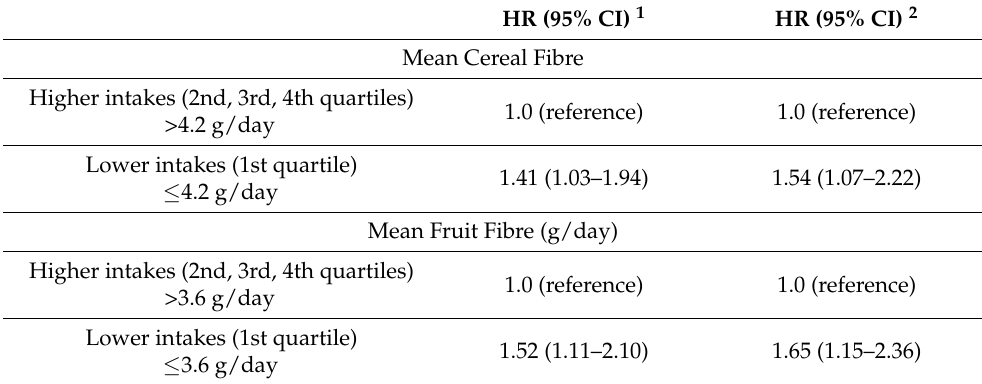
Table 3. Association between mean intakes of cereal and fruit fibre and the 10-year incidence of tinnitus. HR (95% CI) 1 HR (95% CI) 2 Mean Cereal Fibre Higher intakes (2nd, 3rd, 4th quartiles) >4.2